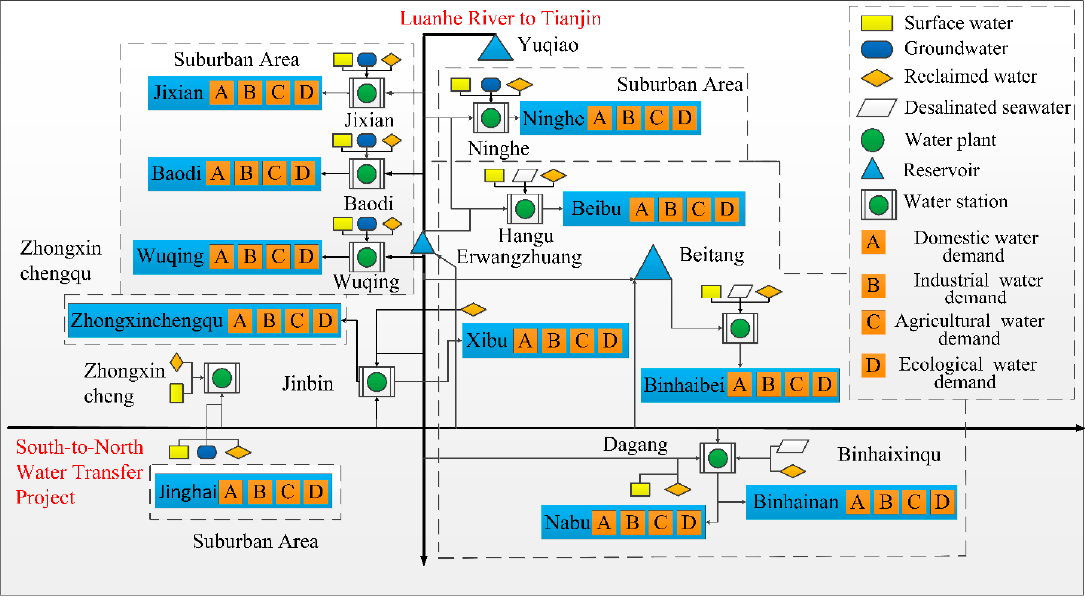
Figure 1. ( a ) Administrative and water distribution map for Tianjin. ( b ) Generalized water supply network. Two straight lines represent the main water supply line of the South-to-North Water